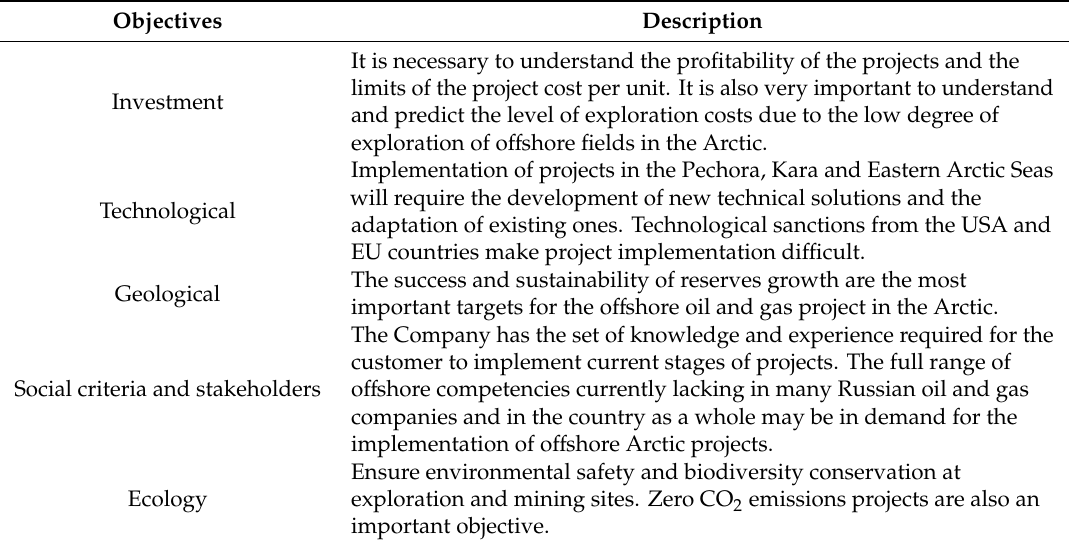
Table 1. Strategic sustainability goals for marine projects in the